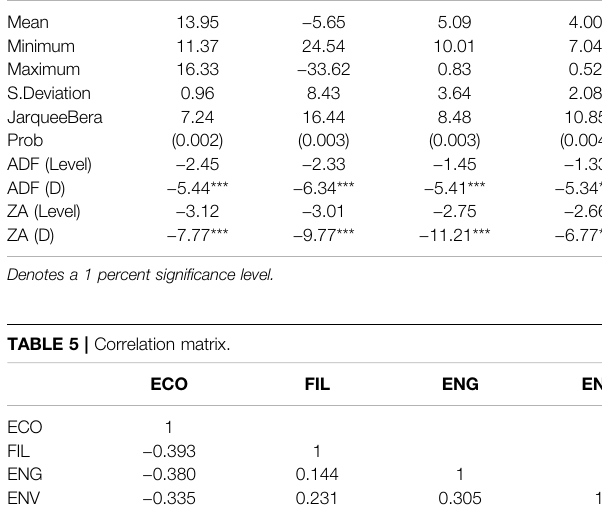
TABLE 4 | Unit root test results and statistics summary. Variable